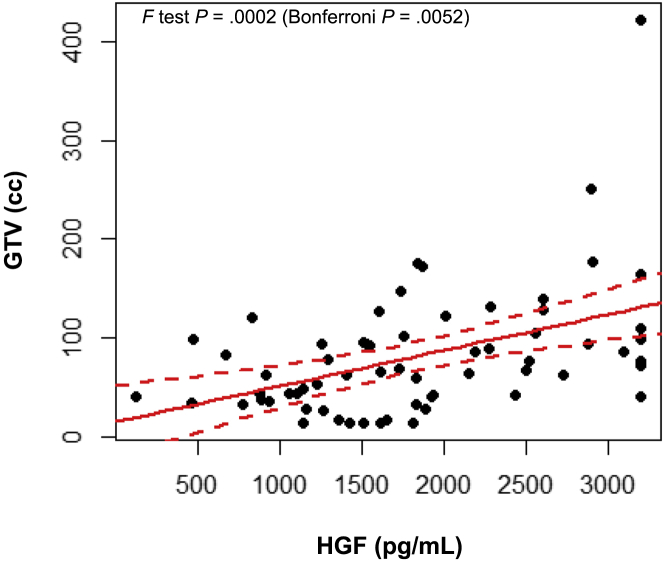
Correlation Between Baseline hepatocyte growth factor (HGF) and Gross Target Volume (GTV; Solid Red Line) With 95% CI (Red Dashed Lines)